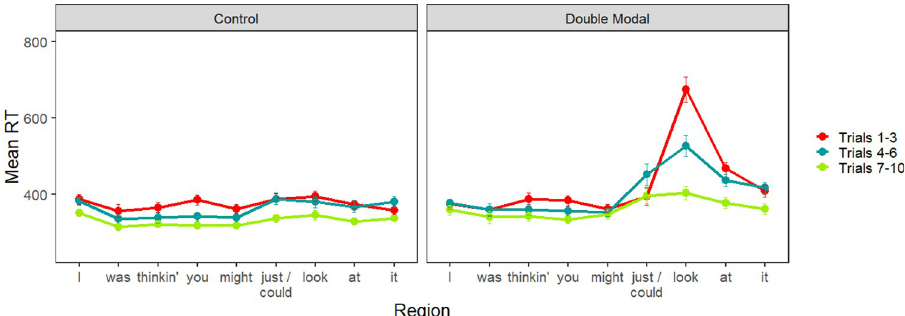
Fig 4. Experiment 2 exposure block. Mean reading times for critical sentence regions by trial number grouped by early (trials 1–3), middle (trials 4–6) and late (trials 7–10). Data from the Control group are on the left, while data from the Double Modal group are on the